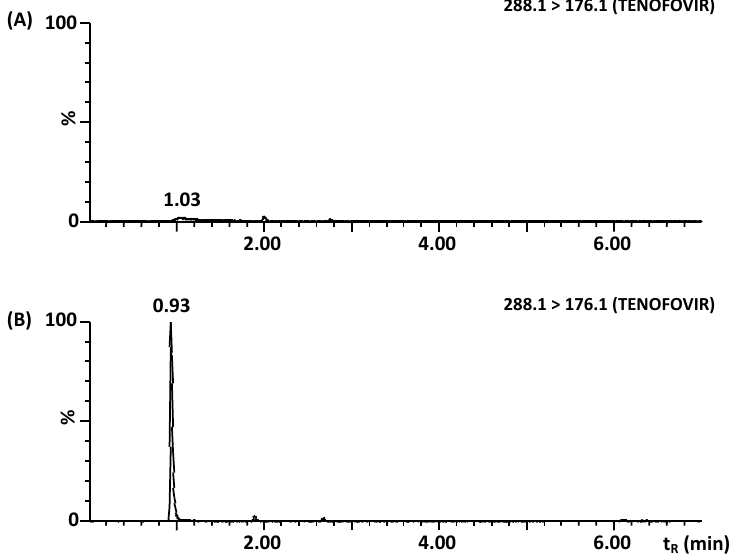
Figure 1. Comparison of RP-UHPLC-MS/MS chromatograms of tenofovir without ( A ) and with ( B ) the addition of 0.1% medronic acid in both components of the mobile phase. Chromatographic conditions were described in Section 3.2.